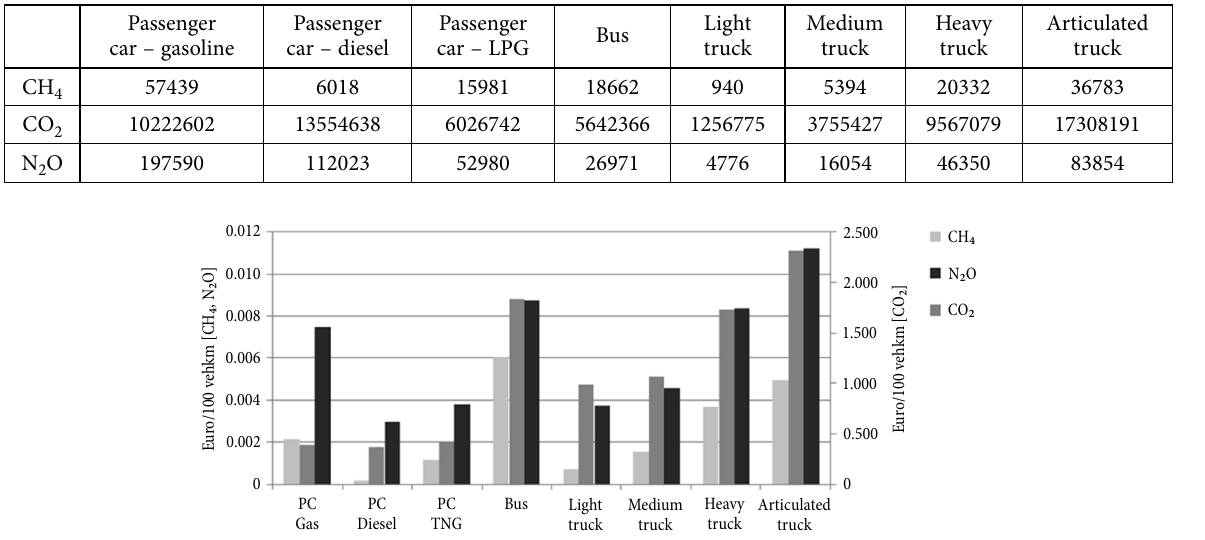
Fig. 3. Specific GHG emission cost per vehicle category